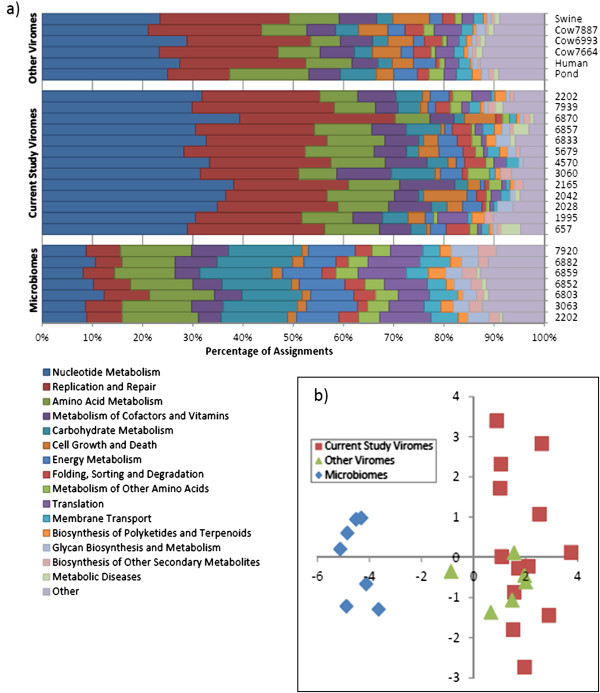
Between animal variation in KEGG pathways. a) Second level KEGG assignments of sequence reads. The “microbes” samples are microbial metagenomes [6]; other viromes include representatives from cattle, human saliva, swine faeces and non host-associated environments [8,18-20]. b) Principle component analysis of the second level KEGG pathways. PC1 (X axis) explains 53.1% of the variation, PC2 (Y axis) explains 13.1% of the variation.